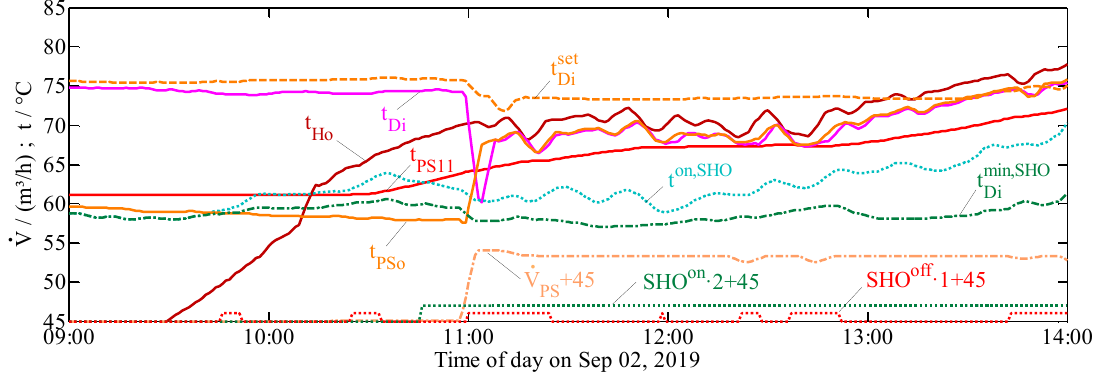
Figure 7. Start-up of solar heat operation with the improved control strategy.